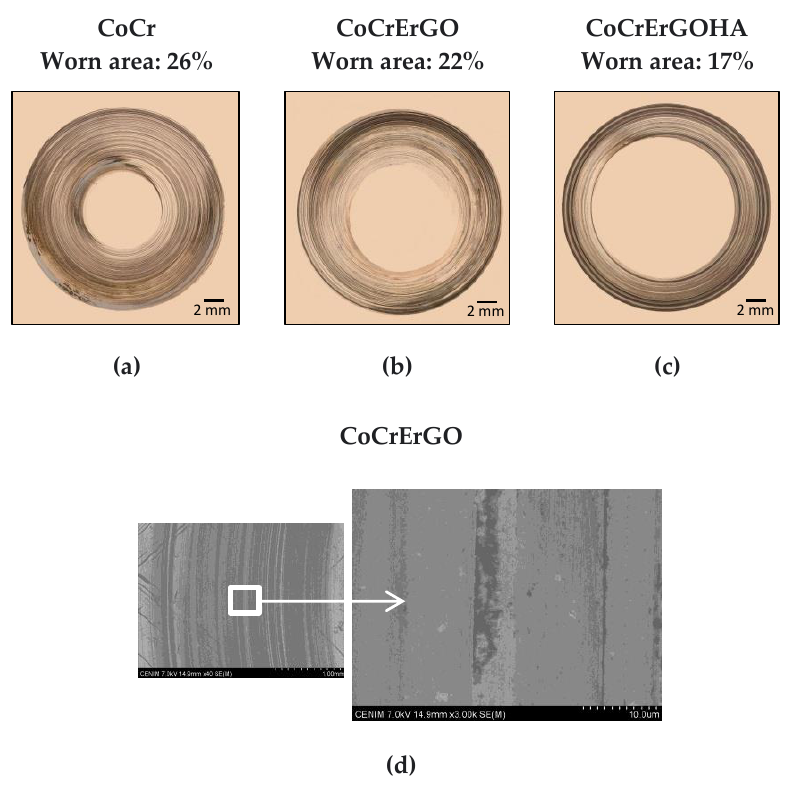
Figure 1. Optical microscopy images of the worn tracks after tribocorrosion tests in CoCr ( a ), CoCrErGO ( b ), and CoCrErGOHA ( c ) after 30,000 m of sliding distance. Scanning electron microscopy image of the worn track after tribocorrosion testing in CoCrErGO ( d ) after 30,000 m of sliding distance.